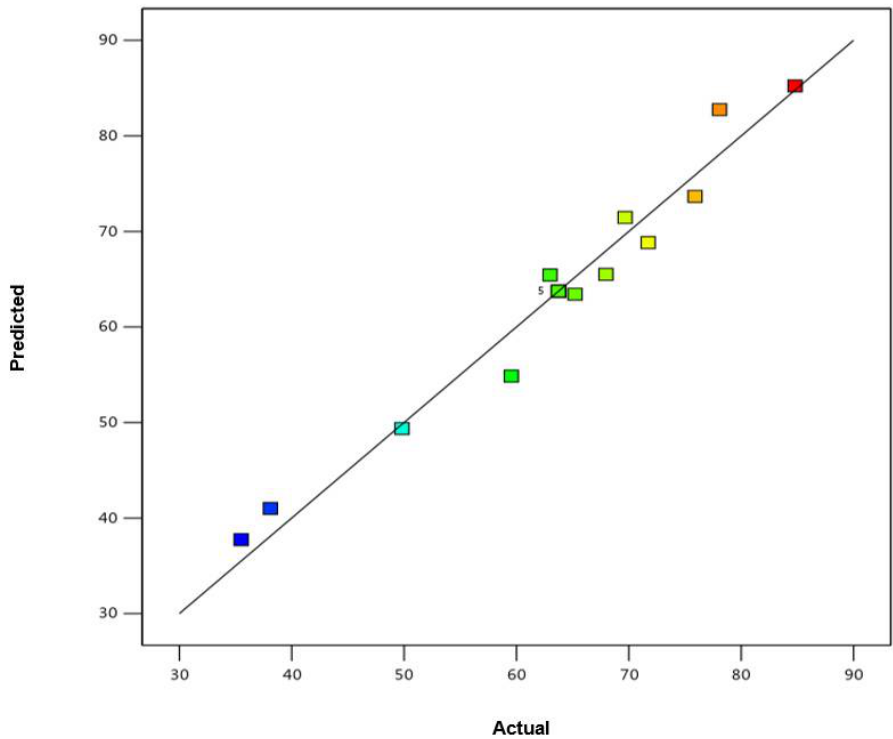
Figure 4. Actual verses predicted graph for the RDX degradation with Paenibacillus dendritiformis.